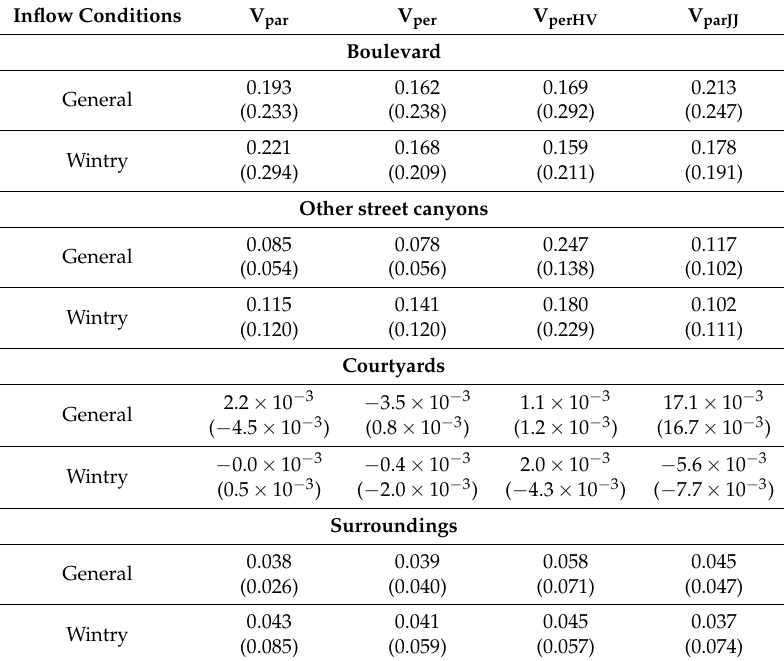
Table 3. Horizontal mean of the high-frequency vertical turbulent particle flux density F p , HF (m − 2 s − 1 ) separately for the boulevard, other street canyons, courtyards and surroundings at z = 20 m under both general and wintry inflow conditions. Horizontal mean of the low-frequency vertical turbulent particle flux density F p , LF over the same domain is given in